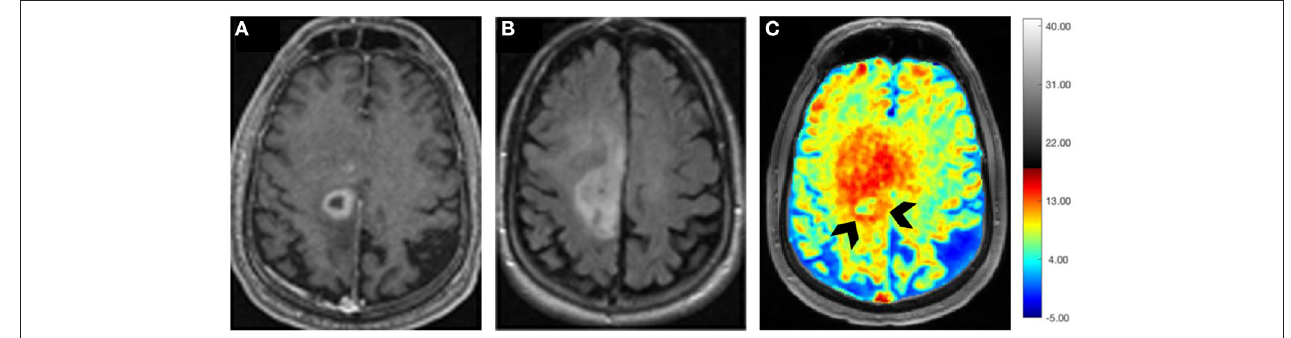
FIGURE 6 | Axial postcontrast T 1 weighted image (A) demonstrating a ring-enhancing GBM with hypointense vasogenic edema in the left frontal lobe, which is visible as a hyperintense mass on the corresponding T 2 -FLAIR image (B) . B 0 and B 1 field in-homogeneity corrected Glu-CEST map (C) showing high glutamate signals from contrast-enhancing ring (arrowheads) and the surrounding brain regions beyond the contrast enhancement, suggesting infiltrative nature of this